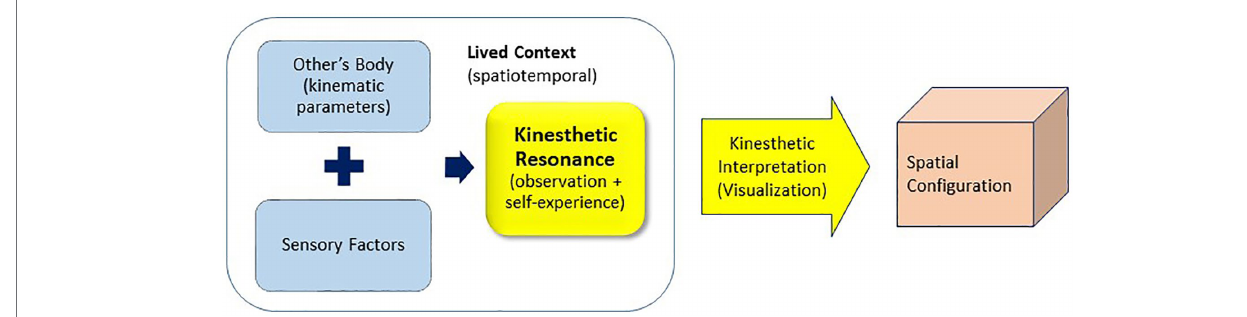
FIGURE 6 | Kinesthetic resonance model for design thinking.